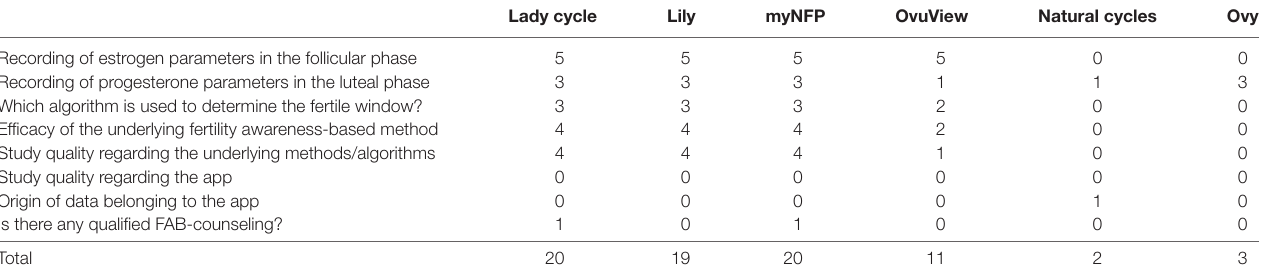
Table 5 | Scoring results of the symptothermal and calculothermal